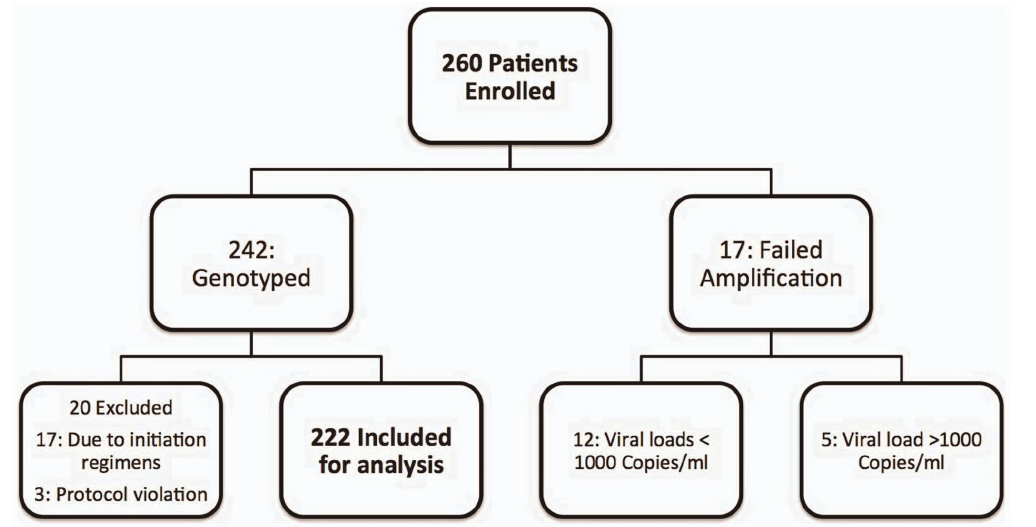
Figure 1. Flow chart showing patients excluded from analysis. Of the 20 excluded patients, 17 were initiated on TDF-based first-line therapy, dual NRTI therapy or were already receiving a second-line regimen at time of genotype. The three protocol violations were: two patients on treatment for less than a year, and one with viral load , 1000 copies/ml at the time of genotyping.